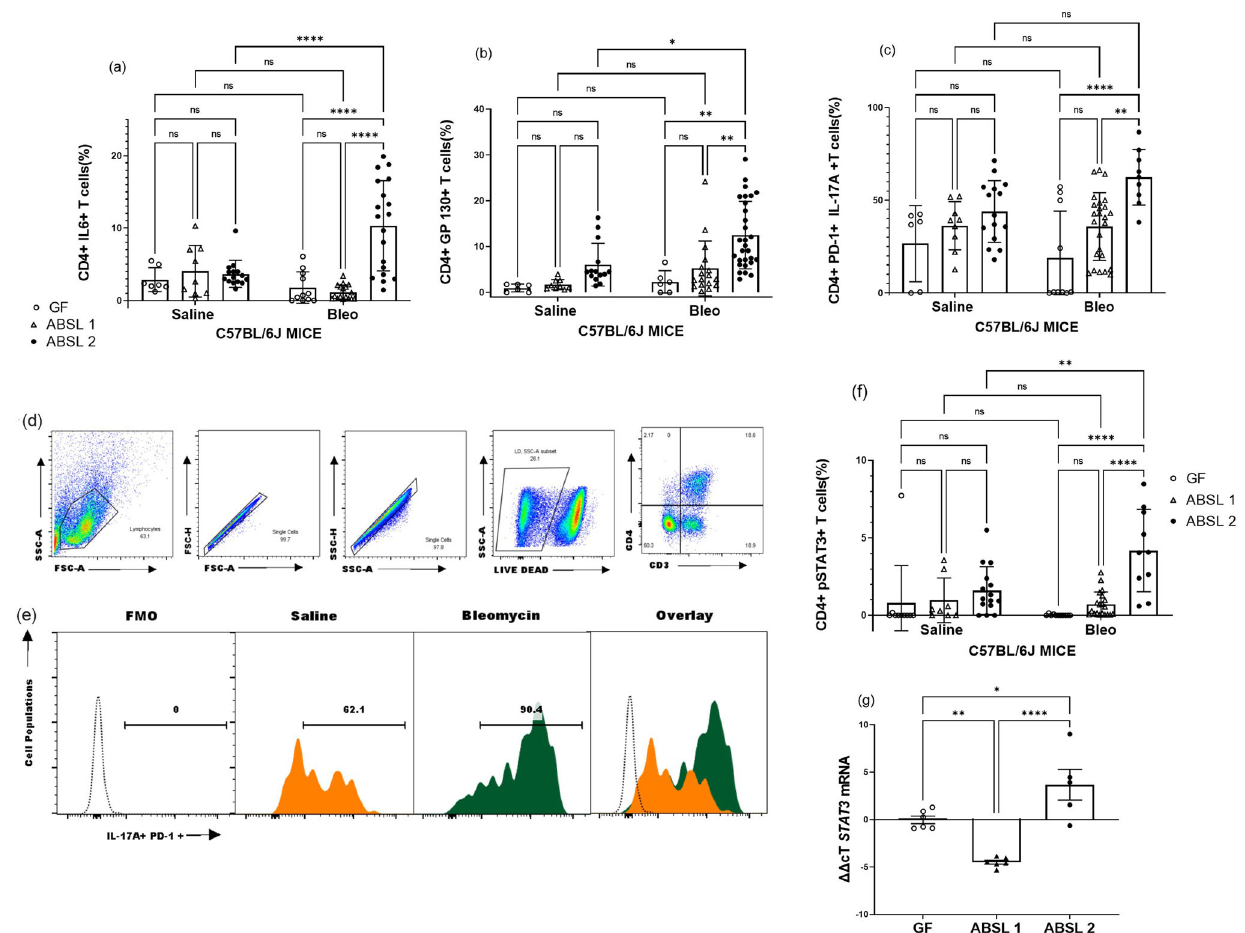
Fig. 4 Germ-free mice do not mount a proin fl ammatory response upon bleomycin treatment. Micewerehousedingermfree,ABSL-1,orABSL-2facilitiesand intranasally inoculated with 75 μ l containing 0.04 Units of bleomycin nor saline (control). 14 days postinoculation, mice were sacri fi ced and single-cell lung suspension prepared form the lungs. Flow cytometric analysis of T cells from single cell were conducted for CD4 + a IL-6, b gp130, c PD-1 + IL-17A + , d gating strategy, e representative histograms from ABSL 2 cohort and f pSTAT3Y 705 expression on T cells. g Relative expression of STAT3 mRNA in lung tissue. Comparisonsbetweencohortswereperformedusingtwo-wayANOVAwithTukey ’ spost-hoc.* P <0.05,** P <0.01,*** P <0.001,**** P <0.0001,ns:nosigni fi cance. Bars are mean±SD; each symbol represents an individual mouse, n = 6 – 29 mice. The experiments were independently conducted an average of two times.